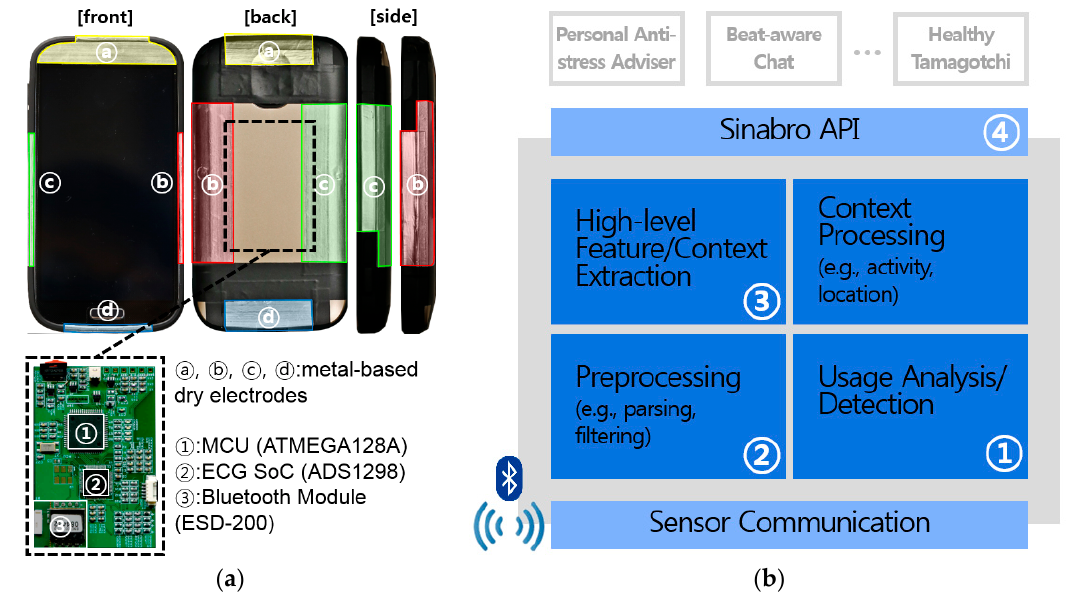
Figure 2. The prototype of the Sinabro sensor device and the architecture of the middleware: ( a ) the prototype of the phone case-type sensor; ( b ) the architecture of the Sinabro middleware.